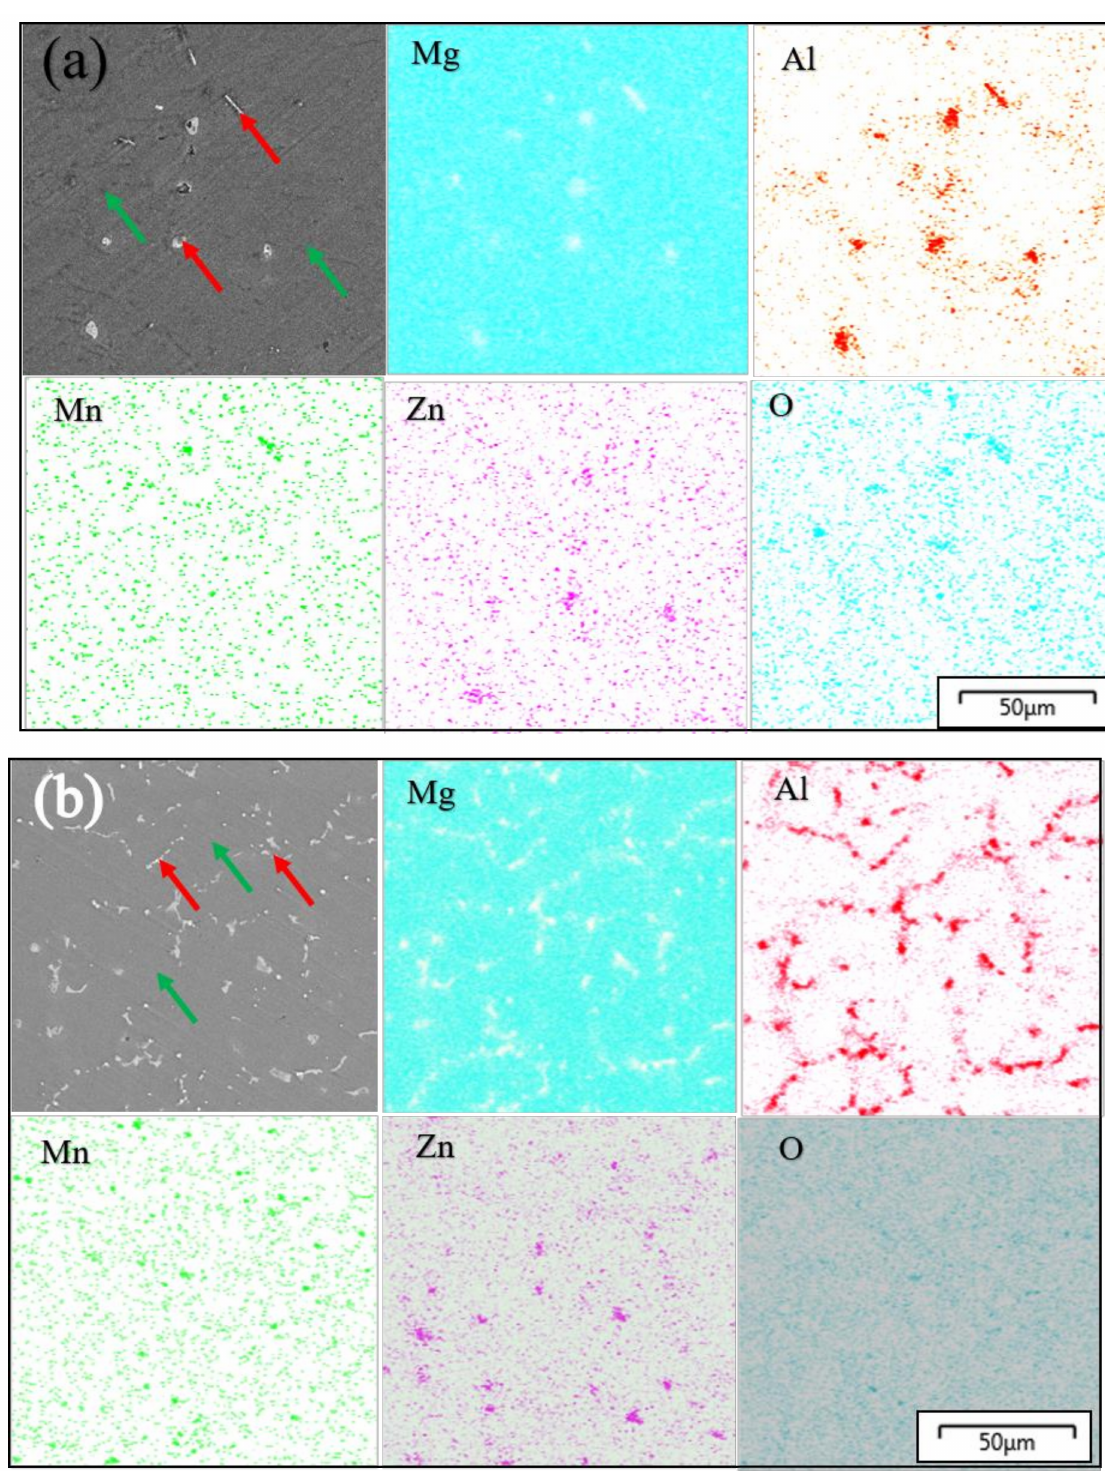
Figure 2. SEM images followed by EDS mapping analysis of ( a ) AZ31 and ( b ) AZ31/ WS 2